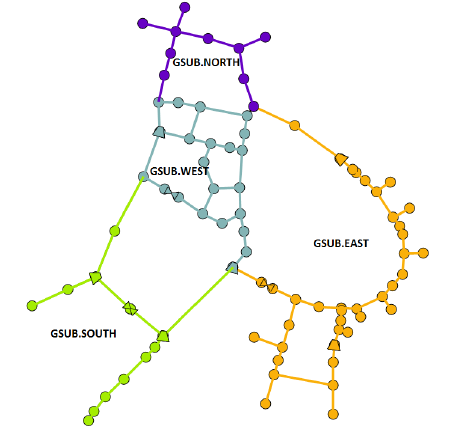
Figure 3. GNET90 gas network showing the topology of the network with the four defined